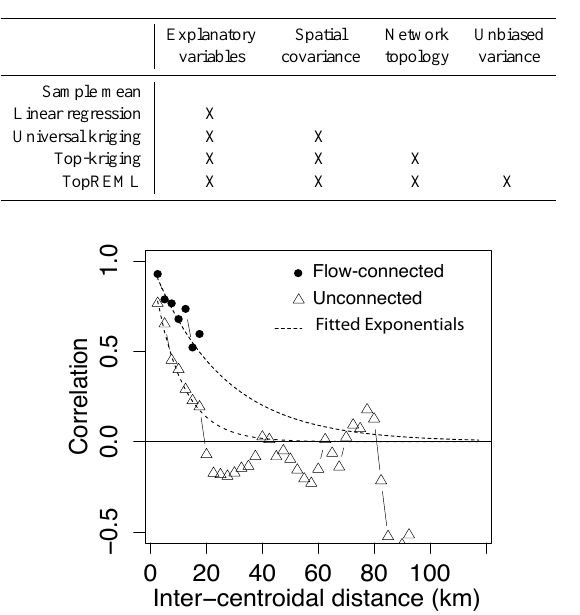
Table 1. Taxonomy of the compared regionalization approaches.